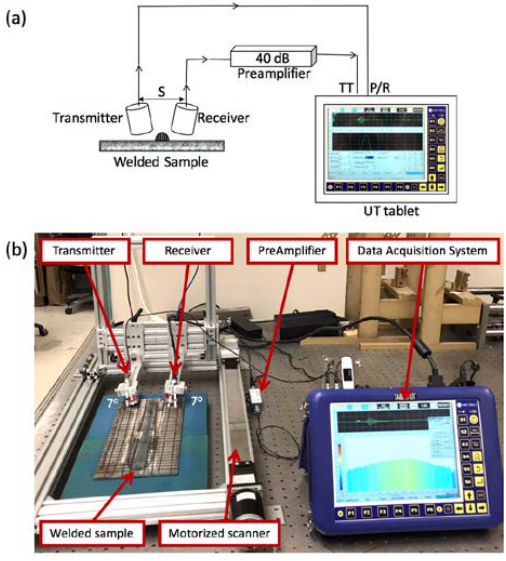
Figure 6. The experimental setup of air-coupled ultrasonic testing: ( a ) schematic; ( b ) photograph. A portable dual-channel tablet UT manufactured by Mistras Group (Princeton Junction, NJ, USA) (with a sampling frequency of 100 MHz) was used to generate a two-cycle tone burst signal. First, the excitation signal was amplified with a gain of 52 dB (with a voltage amplitude of 400 volts), and then received through a preamplifier (designed by Mistras Group) with a gain of 40 dB to address the poor energy transfer of the air-coupled transducers as shown in Figure 6b, as the transmission loss from air to steel is approximately −45 dB [25]. To improve the signal to noise ratio, 200 waveforms were averaged and filtered with a passband of 0.2–10 MHz.